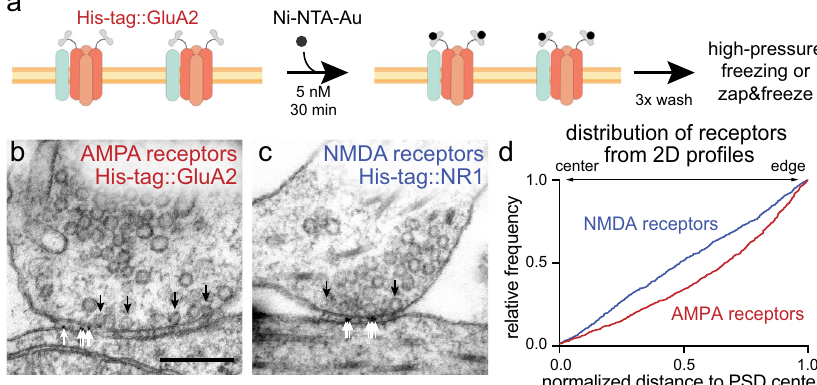
Fig. 1 AMPA and NMDA receptors cluster at the periphery and the center of the postsynaptic density, respectively. a Schematic of the small-metal af fi nity staining of His-tag (SMASH) strategy for live-cell labeling of overexpressed His-tagged surface GluA2 (AMPA receptors) with nickel-NTA-gold (5 nm). Example transmission electron micrographs of synapses after SMASH labeling and high-pressure freezing, showing gold particles in the synaptic cleft of wild-type neurons expressing His-tag::GluA2 ( b ) and His-tag::NR1 ( c ). Black arrows: docked synaptic vesicles. White arrows: gold particles. d Cumulative relative frequency distribution of lateral distances from gold particles to the center of the postsynaptic density (PSD) from 2D pro fi les. Distances are normalized to the length of the PSD: a gold particle at 0 would be exactly at the center and at 1 exactly at the edge. AMPA receptors are biased toward the edge (median = 0.7, p < 0.001, n = 891 particles, N = 4 cultures), while NMDA receptors are uniformly distributed (median = 0.5, p > 0.8, n = 746 particles, N = 4 cultures). Bias of particle locations toward the center or edge of the postsynaptic density in ( d ) was tested by comparing each group to a theoretical median of 0.5 using one-sample two-tailed Wilcoxon signed-rank tests. See Supplementary Data Table 1 for full pairwise comparisons and summary